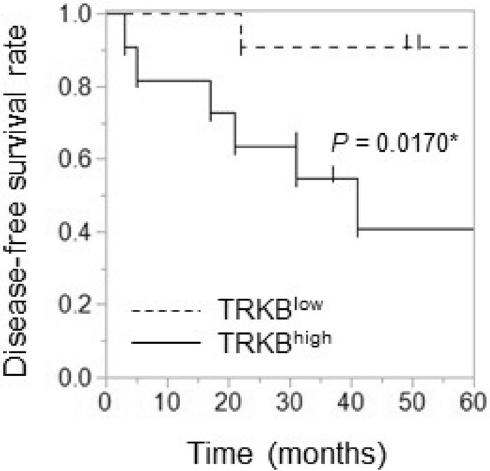
Figure 6. Poor prognosis in patients with PGC with high TRKB expression. Relationships between 5-year disease-free survival and expression levels of TRKB were analyzed using the Kaplan − Meier method. * P <